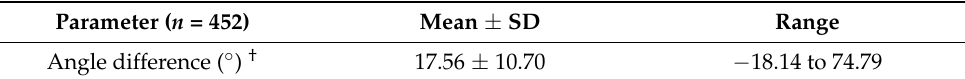
Table 2. Measurement of an angle on translabial ultrasound (TLUS) in 452 patients with symptoms of pelvic organ prolapse.